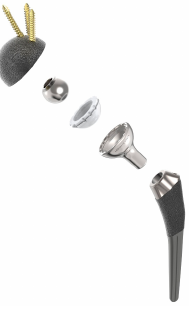
Figure 1. Hip Innovation Technology (HIT) Hip Replacement System (HRS).